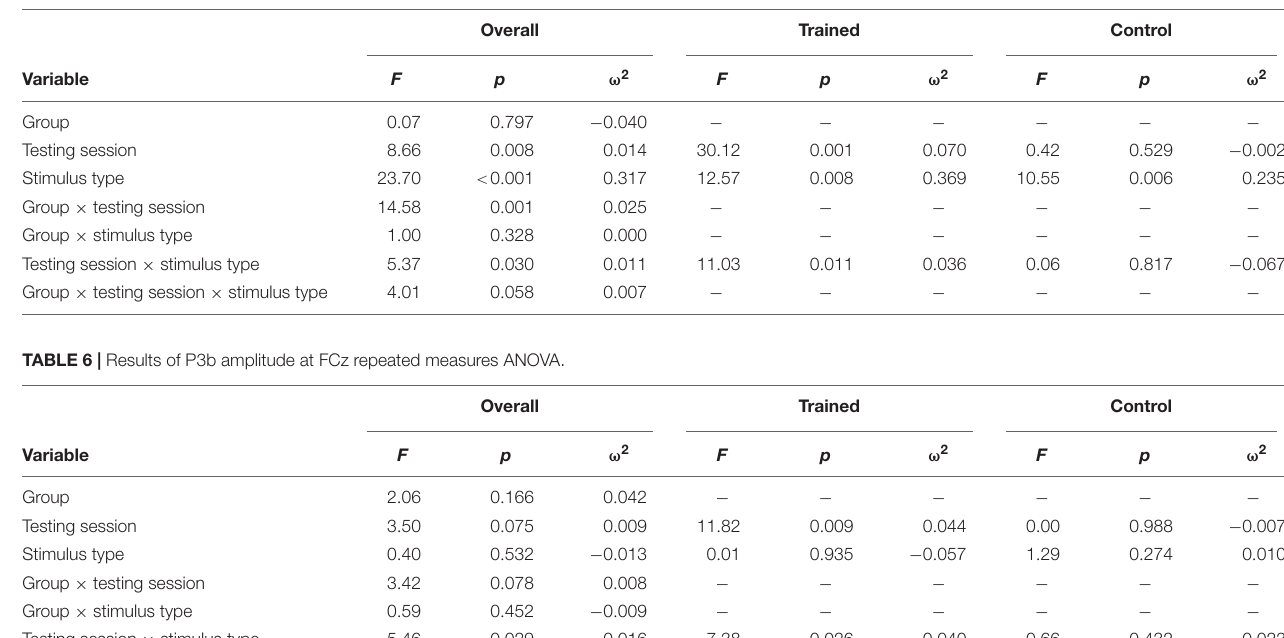
TABLE 5 | Results of P3b amplitude at Pz repeated measures ANOVA.